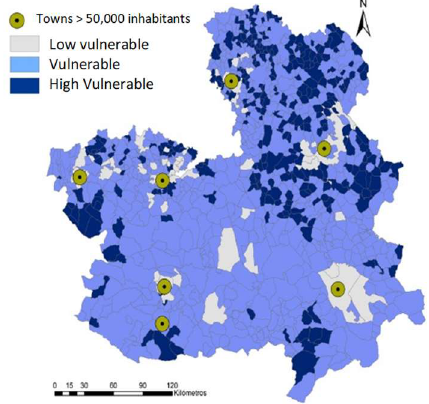
Figure 1. Vulnerability in Castilla-La Mancha, Source: [29] (p. 189).